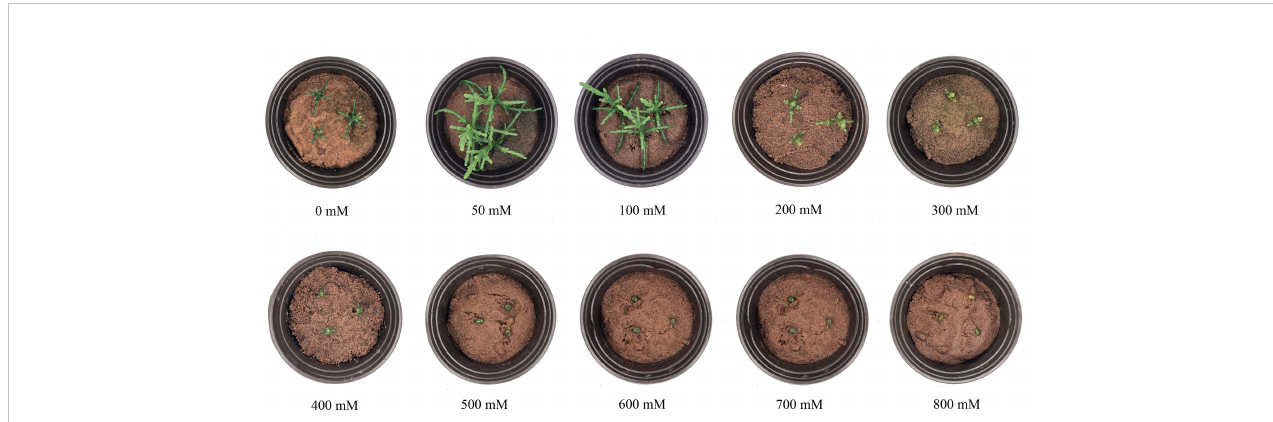
FIGURE 1 Growth performance of Salicornia europaea seedlings exposed to different levels of salt stress for 30